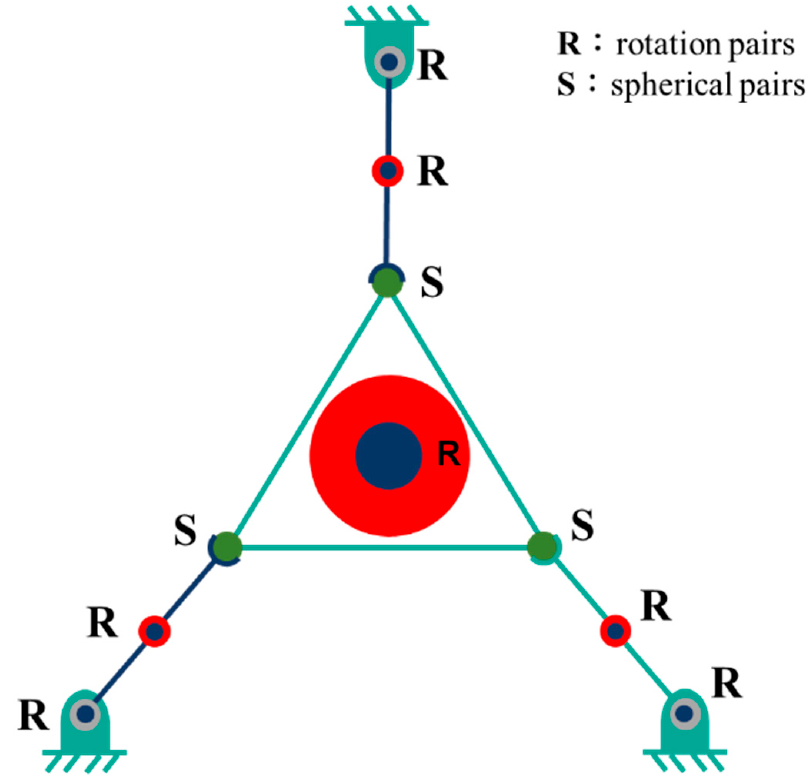
Figure 2. Schematic illustration of the mechanism platform. The DoF calculation is described by Equation (1). This platform had nine component pairs, three spherical pairs, and six rotation pairs. This platform was contained at the central axis of rotation, so DoF can be calculated by Equation (1),